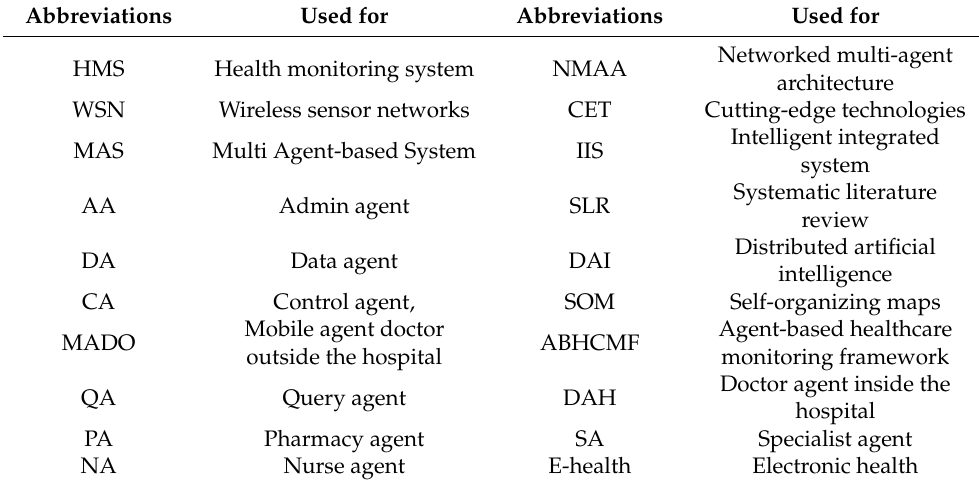
Table 1. List of abbreviations